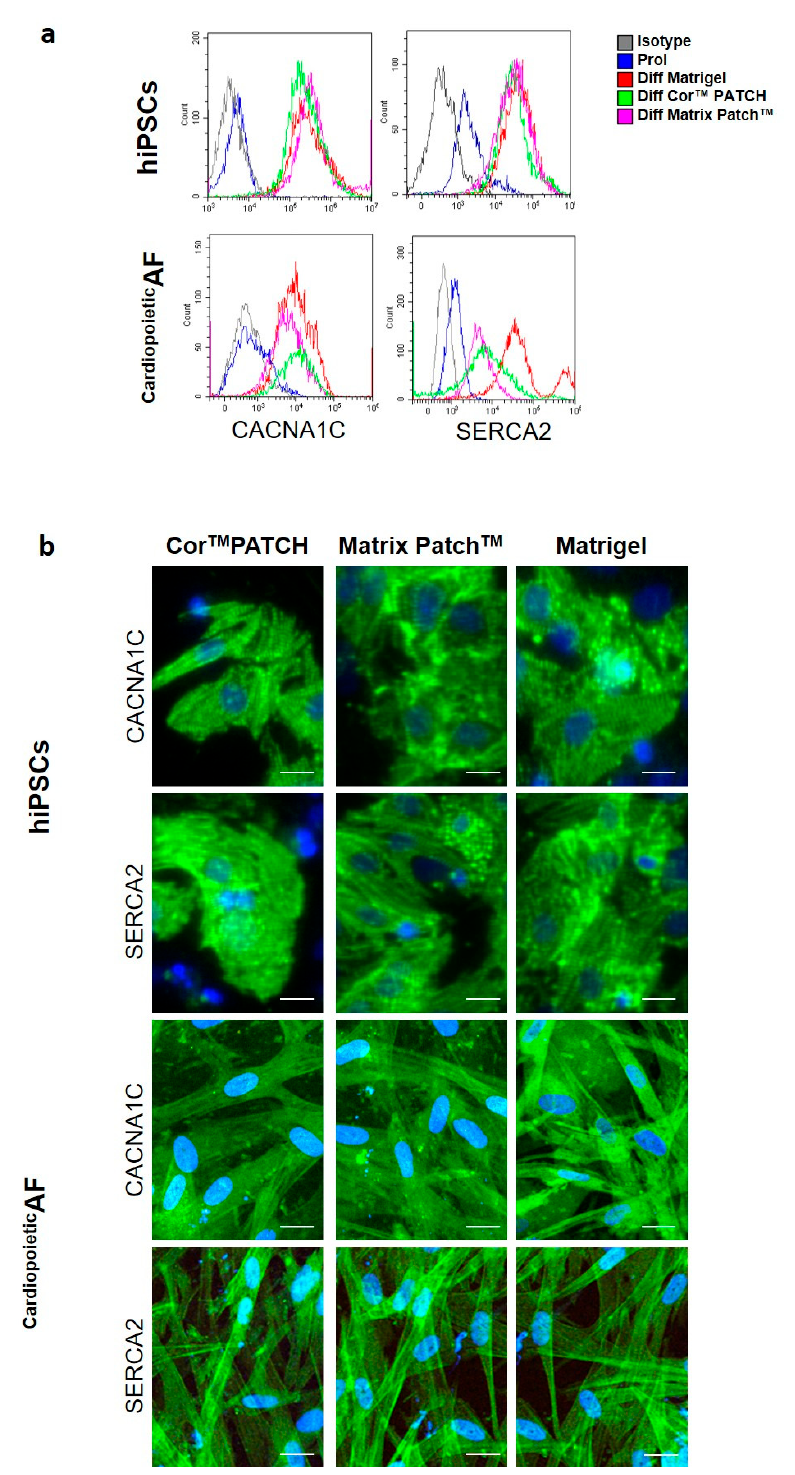
Figure 4. Detection of calcium pumps CACNA1C and SERCA2 in hiPSC- and Cardiopoietic AF-derived CMs obtained after 15 days of differentiation. ( a ) Flow cytometry analysis of CACNA1C and SERCA2 on hIPSCs and Cardiopoietic AF cells, as indicated. Legend of histogram colors: Grey: isotype control; blue: proliferating cells; red: differentiation on Matrigel ® ; green: differentiation on Cor TM Patch; purple: differentiation on Matrix Patch TM . ( b ) Immunofluorescent staining for CACNA1C and SERCA2 (green) in hiPSCs and Cardiopoietic AF cells, as indicated. Nuclei were counterstained with DAPI (blue). Scale bar: 10 µ m. Data are representative of five independent